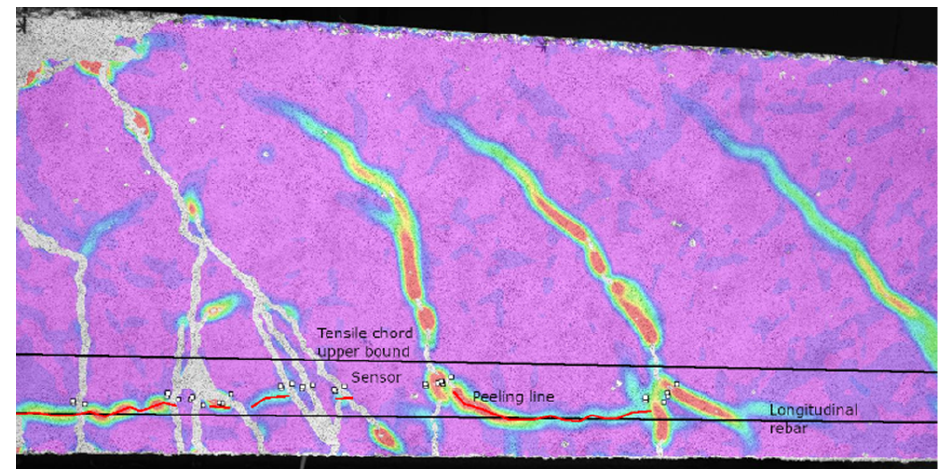
Figure 4. Sensor placement.